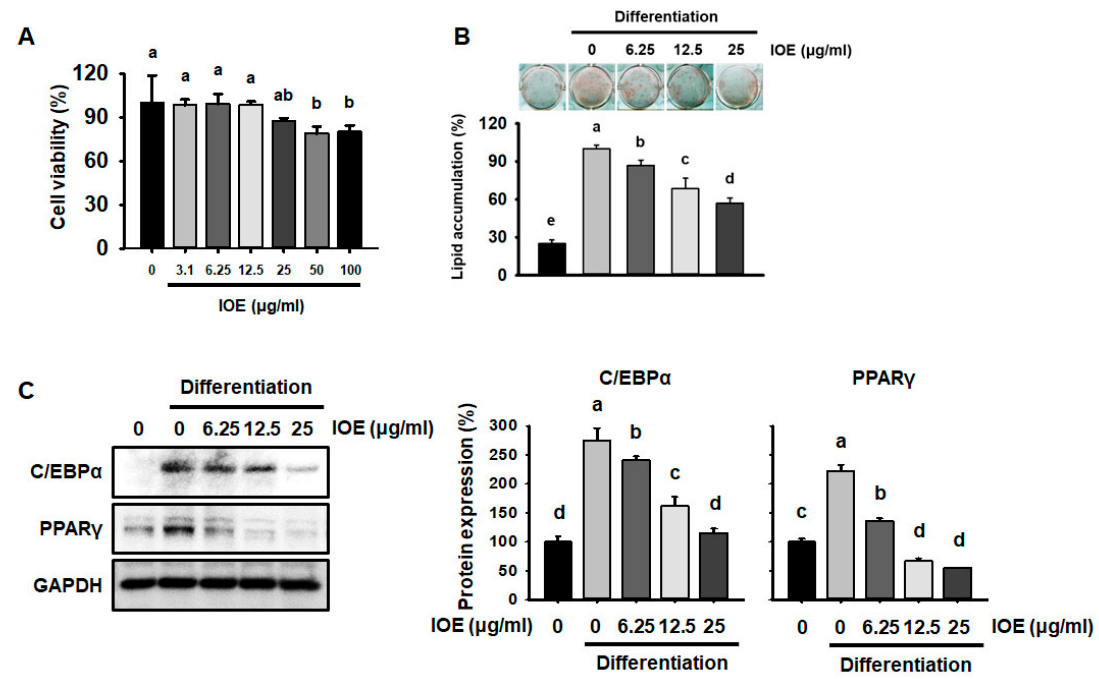
Figure 1. IOE reduces lipid accumulation in 3T3-L1 adipocytes. ( A ) Cell viability of 3T3-L1 preadipocytes treated with IOE, determined over 24 h using an XTT assay. ( B ) Effect of IOE on lipid accumulation, determined using Oil Red O staining, in 3T3-L1 adipocytes. A differentiation-inducing cocktail, with or without IOE, was added to 3T3-L1 adipocytes for 8 days. ( C ) Protein expression of adipogenic transcription factors (C/EBP α and PPAR γ ) after 8 days of incubation of 3T3-L1 adipocytes in differentiation medium. Values with different letters are significantly different; p < 0.05 (a > b > c > d).